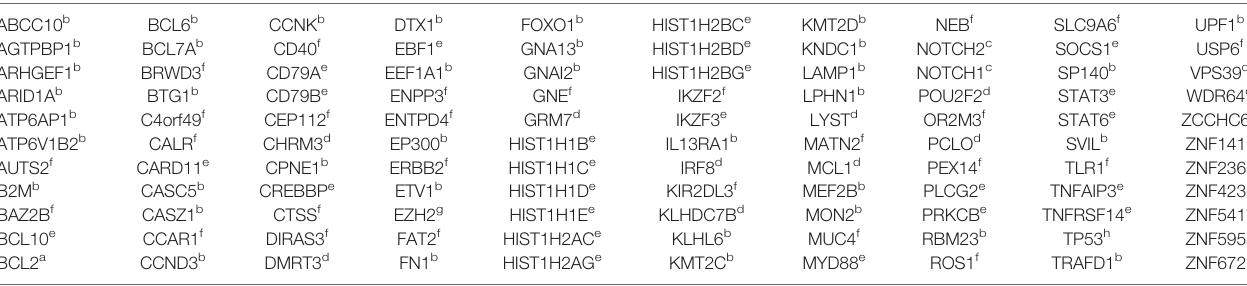
TABLE 2 | The list of 110 genes included in ultra-deep targeted sequencing of follicular lymphoma DNA